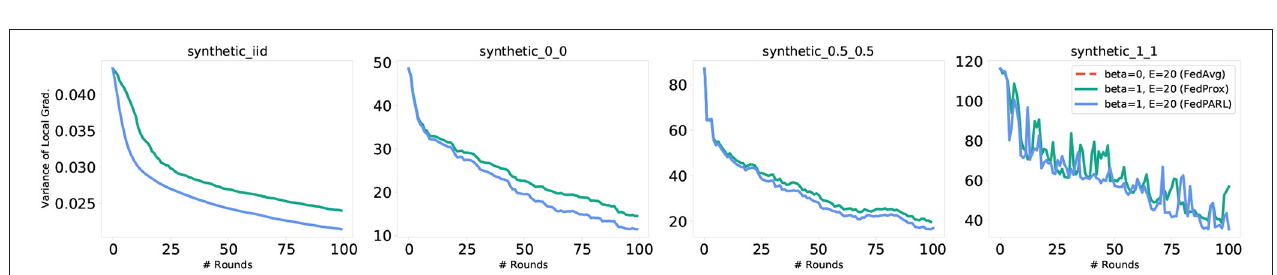
FIGURE 15 | Simulation of data heterogeneity effects on testing accuracy by considering four synthetic datasets. From left to right, the statistical heterogeneity increases.